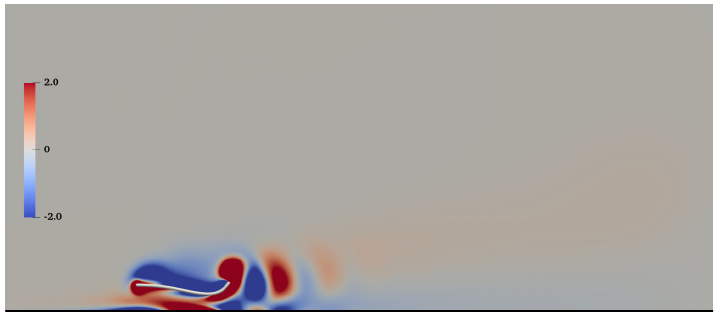
Figure 14. Vorticity contours for the case of ¯ D = 0.4. The black bold horizontal line is the solid wall.